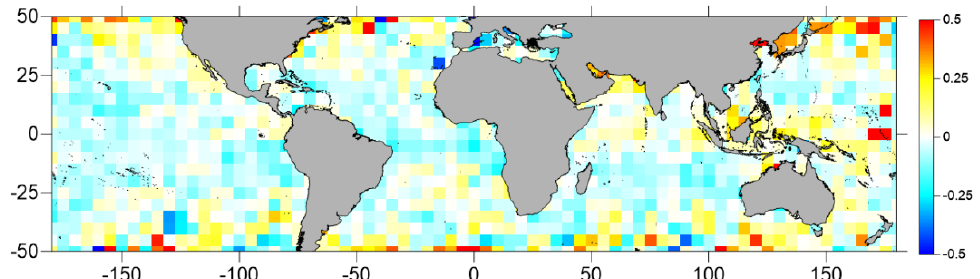
Figure 6. Differences, in cm, between RMS values for Algorithm 3 – Algorithm 4, represented with a 5° by 5° spatial resolution.